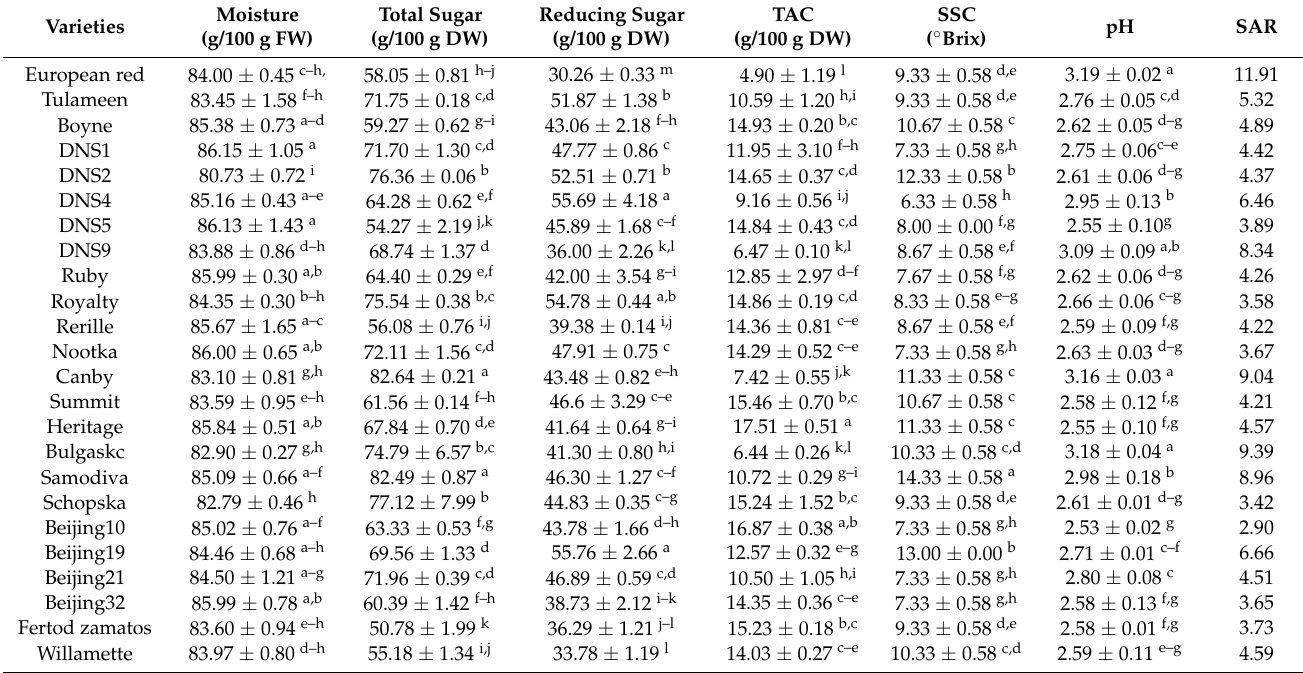
Table 2. The moisture, total sugar, reducing sugar, titratable acidity (TAC), soluble solids contents (SSC), pH and sugar-acid ratio (SAR) of 24 red raspberry